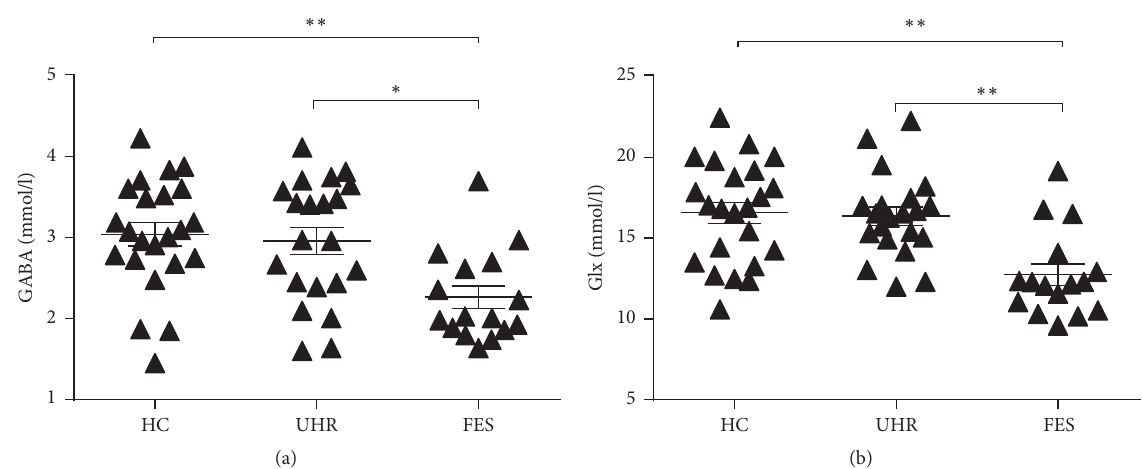
Figure 2: Absolute concentrations of GABA (a) and Glx (b) among FES patients and UHR and HC subjects. Lower GABA and Glx concentrations were observed in FES patients than UHR and HC subjects ( ∗ for 𝑃 < 0.05 and ∗∗ for 𝑃 < 0.01 ).